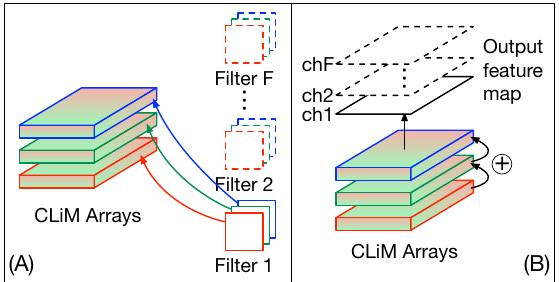
Figure 15. Data reuse in CLiMA. ( A ) Filters are reused across input feature maps according to the sliding window process. Input feature maps are also reused by different filters. ( B ) Partial results are reused for further processing to obtain the final output feature